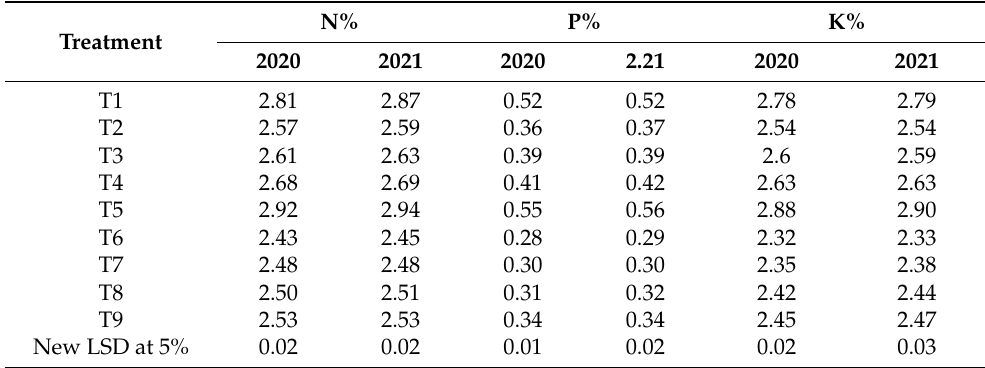
Table 7. Effect of mineral fertilizer indvidual or combined with SAPs on N, P, and K in leaves of Autumn Royal grapevines in 2020 and 2021 seasons. N% P% Treatment